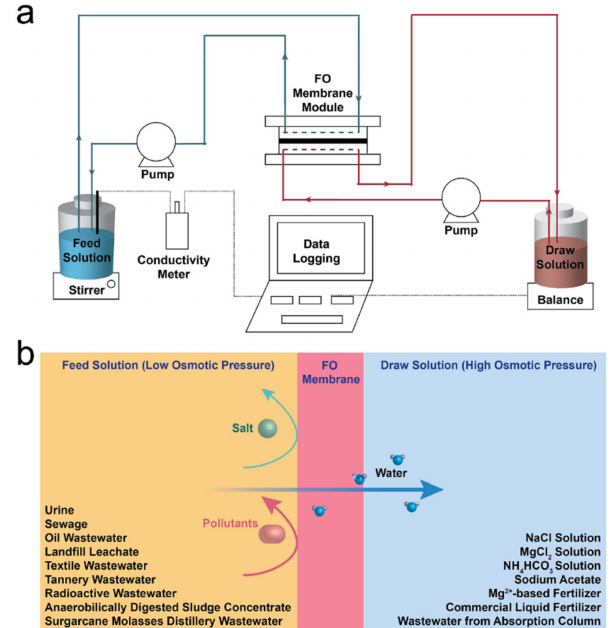
Figure 1. ( a ) Schematic of FO performance evaluation rig set-up, adapted from [33], and ( b ) major wastewater sources and draw solutions reported in FO-based wastewater